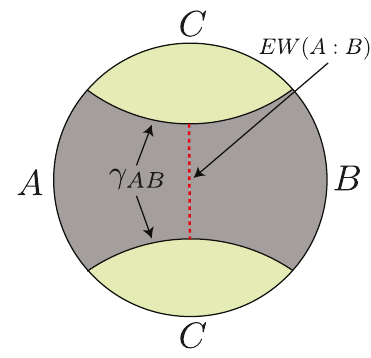
Figure 1 . EW ( A : B ) is the minimal area surface that divides the entanglement wedge of AB , bounded by the RT surface γ , into regions homologous to subregions A and B AB